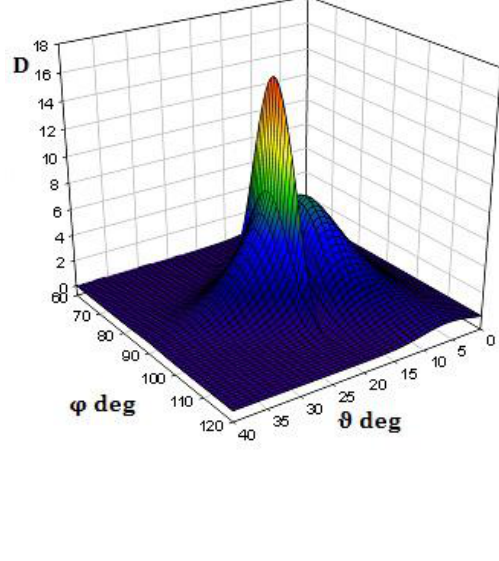
Figure 5b: The incident field pattern Numerical studies have shown that a direction of orientation in space of the axes of ellipse of cross-section beams has a significant influence on the shape of the patterns of the scattered field in the case of p-polarization besides the polarization direction of obliquely incident beams. Thus, at oblique incidence of p-polarized beam, a large axis of the ellipse which is directed along the axis , the patterns of the scattered field have multi-lobe nature (see Fig. 7), which was not observed in the case of s-polarization. This is explained by the difference in amplitude and phase distributions of the electromagnetic field in the plane of the array for these polarizations, different conditions of excitation of the waveguide waves in the waveguide channels, as well as the interference of the field reflected from the plane of the array aperture and the field radiated from the waveguide channels.